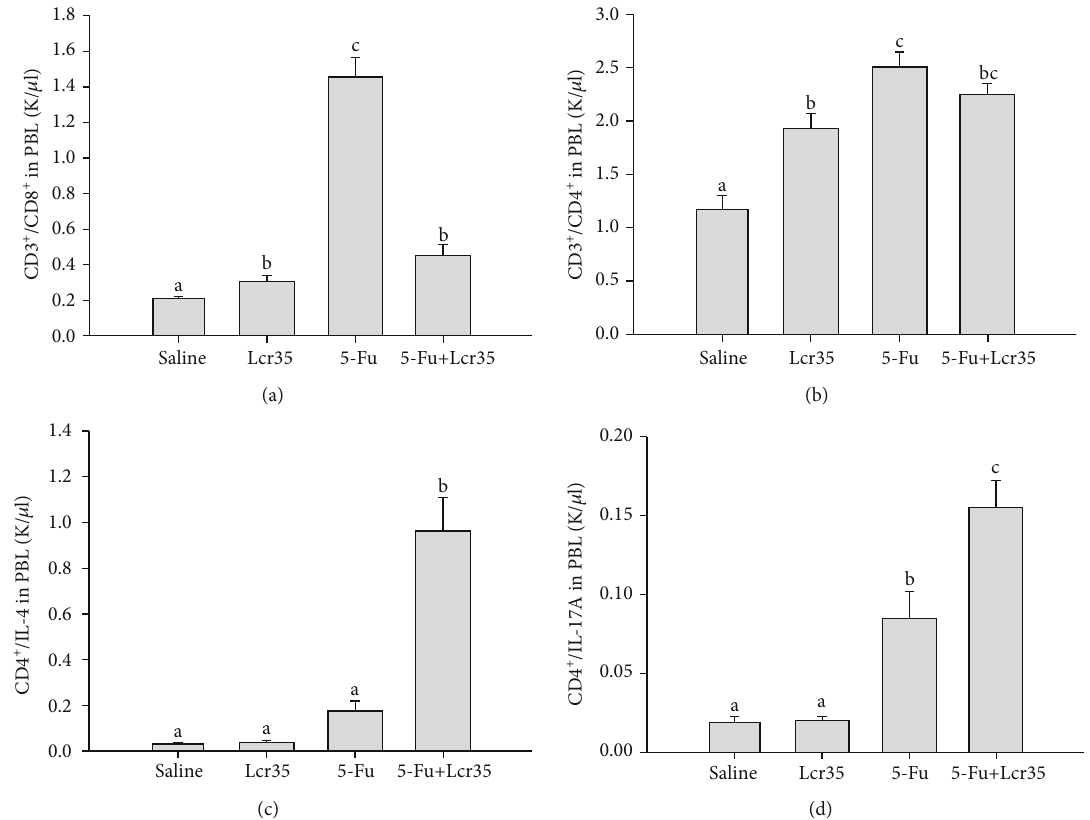
Figure 4: E ff ect of Lcr35 administration on the T lymphocyte count by fl ow cytometry analysis. (a) A tremendous rise of the CD3 + /CD8 + lymphocyte count in the 5-FU group ( 1 : 45 ± 0 : 10 K/ μ l) was observed when compared to that in the saline group ( 0 : 21 ± 0 : 01 K/ μ l). The CD8 T lymphocyte count in the 5-FU+Lcr35 group ( 0 : 46 ± 0 : 04 K/ μ l) was signi fi cantly lower than that in the 5-FU group ( p = 0 : 0001 ). (b) A signi fi cant increase of the CD3 + /CD4 + T lymphocyte count was found in the 5-FU group ( 2 : 50 ± 0 : 15 K/ μ l) when compared to the saline group ( 1 : 16 ± 0 : 14 K/ μ l). The CD3 + /CD4 + T lymphocyte count in the 5-FU+Lcr35 group ( 2 : 25 ± 0 : 08 K/ μ l) was lower than that in the 5-FU group though no signi fi cant di ff erence was found ( p = 0 : 194 ). (c) The CD4 + /IL-4 T lymphocyte count in the 5-FU+Lcr35 group ( 0 : 96 ± 0 : 15 K/ μ l) was signi fi cantly higher than that in the 5-FU group ( 0 : 18 ± 0 : 04 K/ μ l) ( p = 0 : 001 ). (d) A tremendous rise of the CD4 +/IL-17A lymphocyte count in the 5-FU group was observed when compared to that in the saline group. The CD4 + /IL-17A T lymphocyte count in the 5-FU+Lcr35 group ( 0 : 16 ± 0 : 02 K/ μ l) was signi fi cantly higher than that in the 5-FU group ( 0 : 08 ± 0 : 02 K/ μ l) ( p = 0 : 004 ). Statistical analysis was performed by one-way ANOVA.